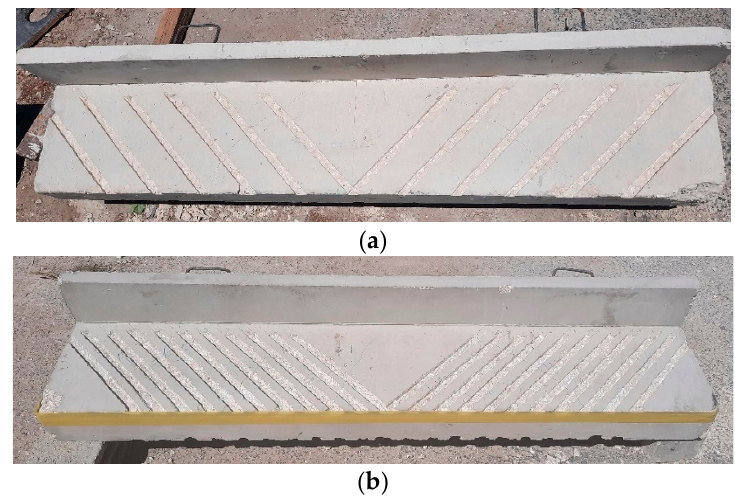
Figure 3. Preparation of grooves for: ( a ) 150 mm spacing; ( b ) 75 mm spacing.